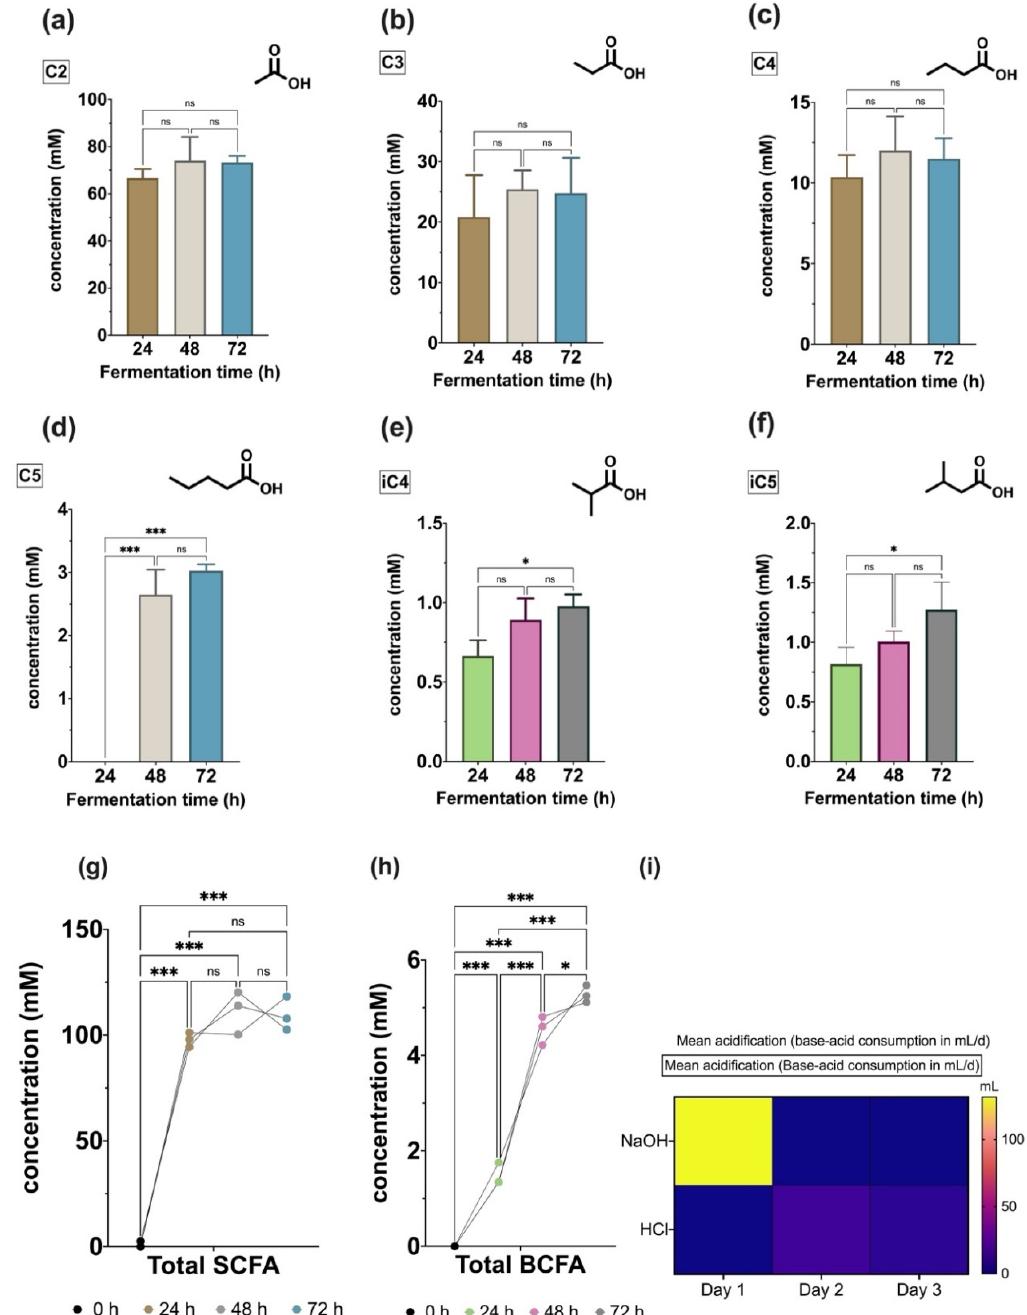
Figure 3. Production of short-chain fatty acids (SCFA) and branched-chain fatty acids (BCFA) and acidification during the in vitro fermentation. Concentrations are expressed in mM for: ( a ) C2: acetate, ( b ) C3: propionate, ( c ) C4: butyrate, ( d ) C5: valerate, ( e ) iC4: isobutyrate, ( f ) iC5: isovalerate, ( g ) total quantification of SCFA, and ( h ) BCFA, all quantified using SPME-GC-MS. ( i ) Recorded consumptions (mL/day) of base (NaOH) and acid (HCl). Data are presented as mean ± SD, and statistical significances (one-way ANOVA comparisons, followed by Bonferroni’s post-test) are shown as p < 0.05 (*), p < 0.001 (***), and p > 0.05